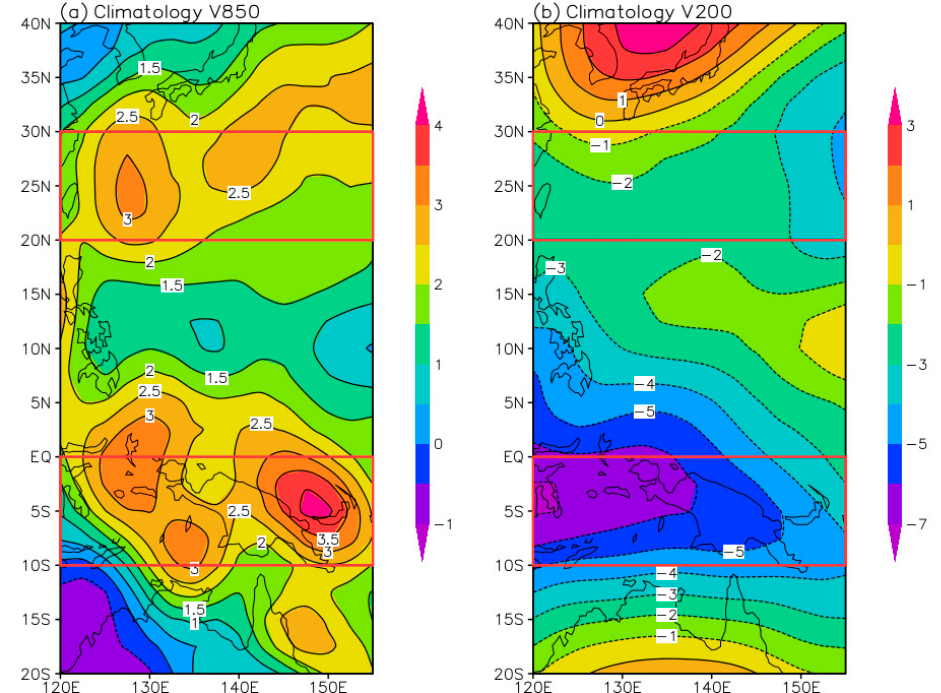
Figure 2. Climatology of meridional wind at ( a ) 850 hPa and ( b ) 200 hPa during summer (June – September, JJAS) from 1979 to 2017 (unit m/s). The red boxes are the maximum meridional wind regions, which are used to define the meridional circulation indices in Northern and Southern Hemisphere.